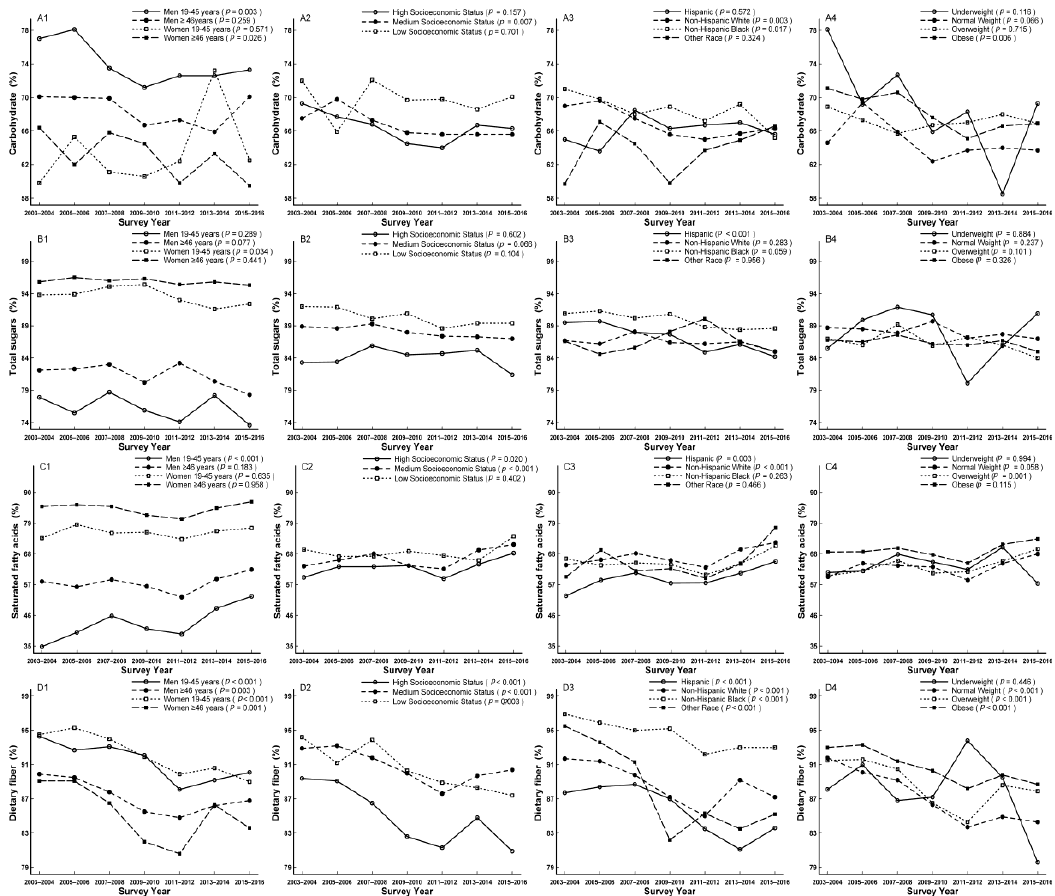
Figure 1. Trends of dietary carbohydrate ( A1 – A4 ), total sugars ( B1 – B4 ), saturated fatty acids ( C1 – C4 ), and fiber ( D1 – D4 ) by sex age, socioeconomic status, race / ethnicity, and body mass index (BMI) for percentage not meeting dietary reference intakes among US adults across seven surveys in the National Health and Nutrition Examination Survey (NHANES